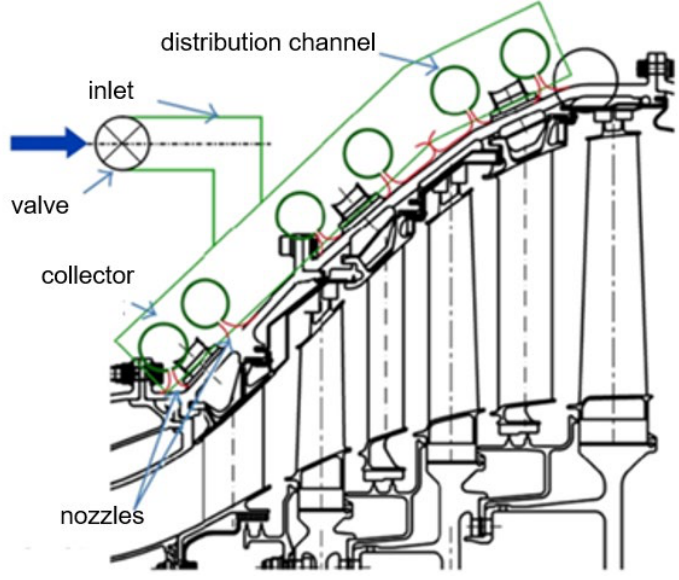
Figure 1. Schematic section of low-pressure turbine equipped with Active Clearance Control (ACC) [2].